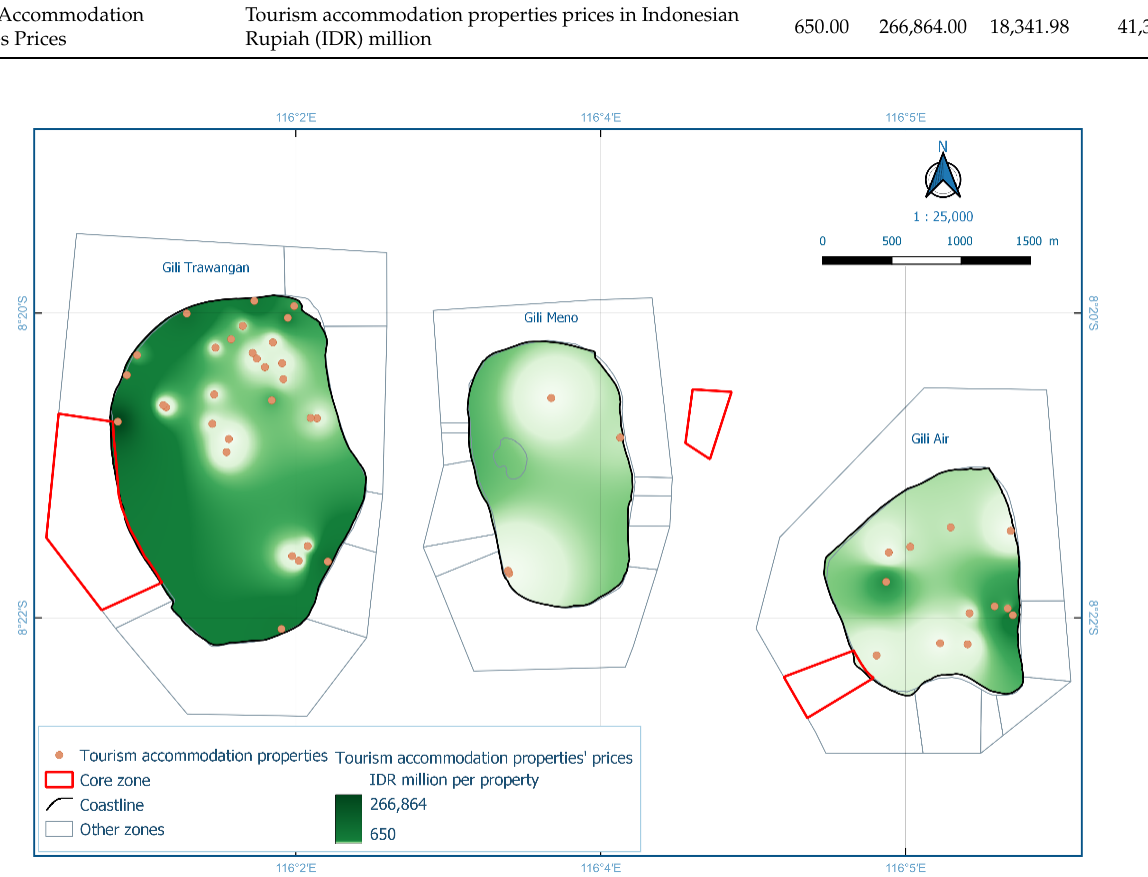
Figure 9. Interpolation of tourism accommodation property prices (Model HT1). Table 3. Statistical summary for model HT1 of tourism accommodation property prices.